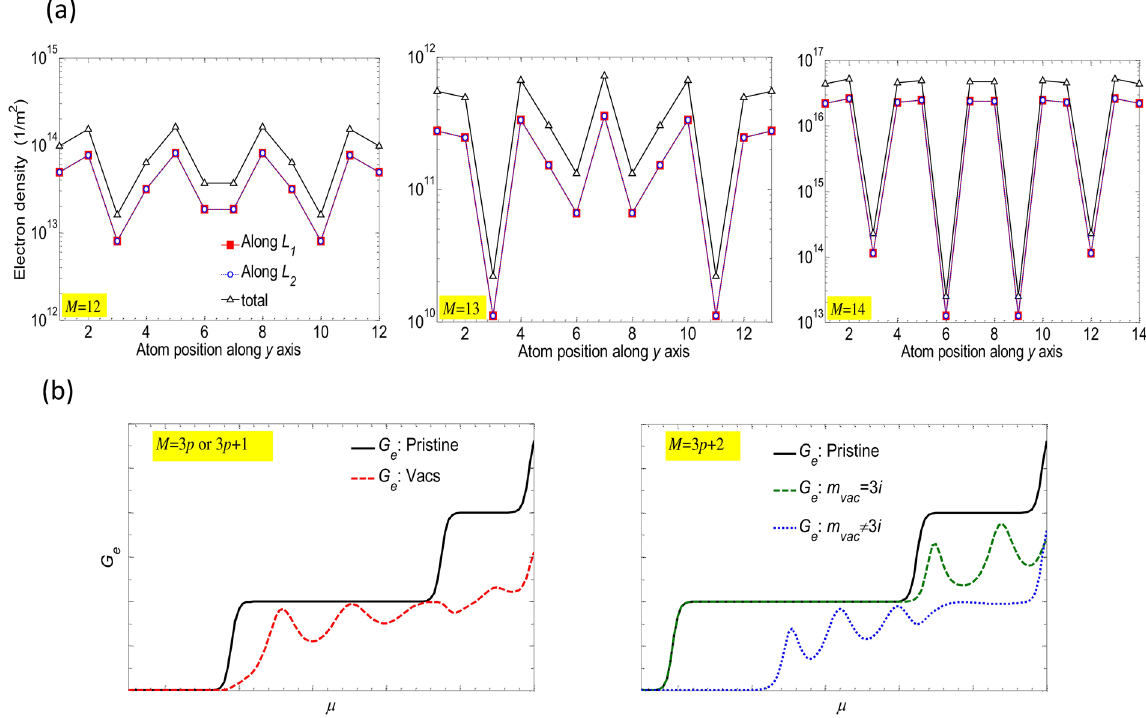
Figure 5. ( a ) Spatial distribution of the electron density in pristine ribbons of width M = 12 (group 3 p ), M = 13 (group 3 p + 1) and M = 14 (group 3 p + 2), charge is minimal at positions m = 3 i from one edge, especially in the group 3 p + 2. ( b ) Pictures of the effect of vacancies on the electrical conductance at different positions for 3 groups of ribbon